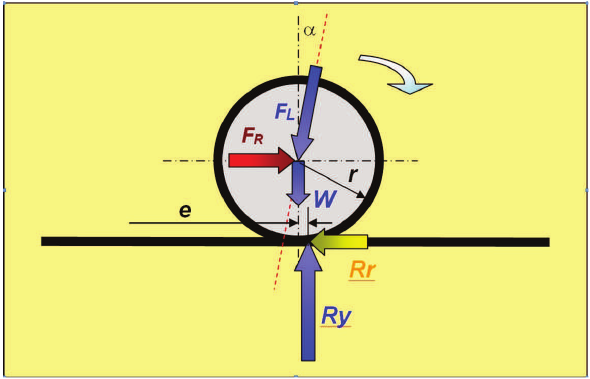
Fig. 3. Influence of imperfections in measuring system on accuracy of rolling resistance measurements